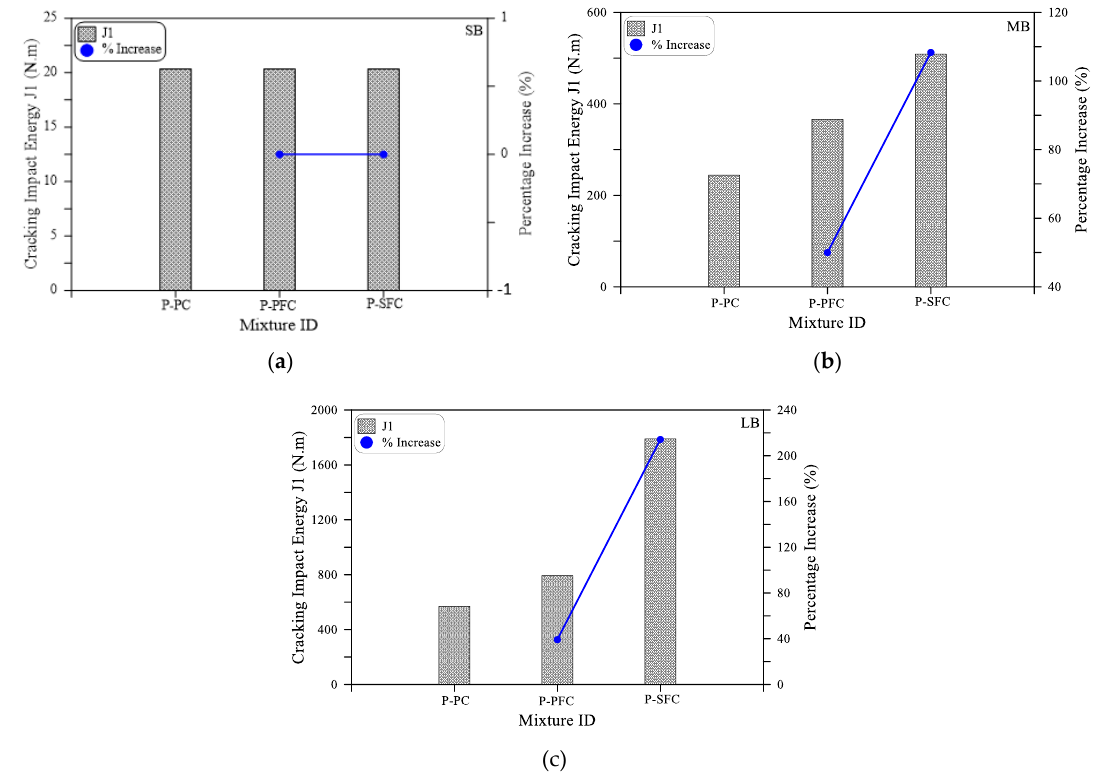
Figure 7. Cracking impact energy (J1) of the three mixtures: ( a ) SB; ( b ) MB; ( c ) LB.